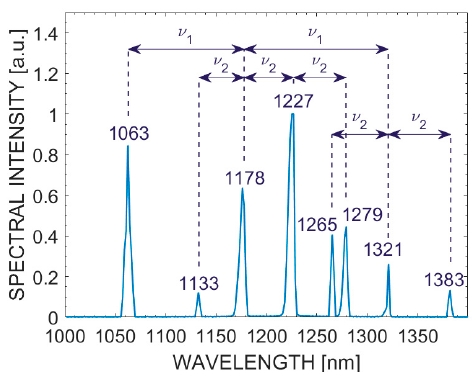
Figure 4. Registered weak SRS radiation spectral components for the short (1.4 cm) SrWO 4 crystal using OC2.